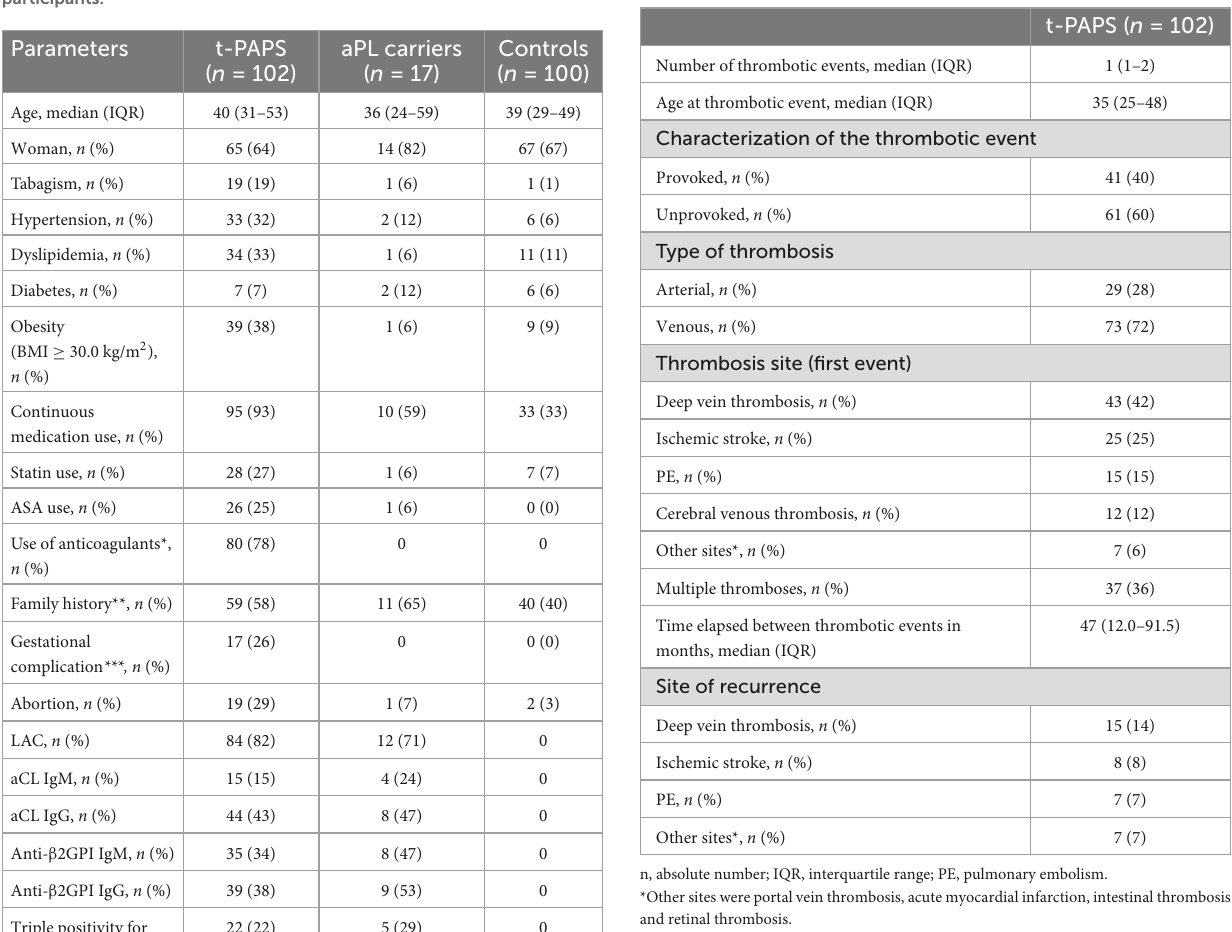
TABLE 2 Thrombotic manifestation in patients with